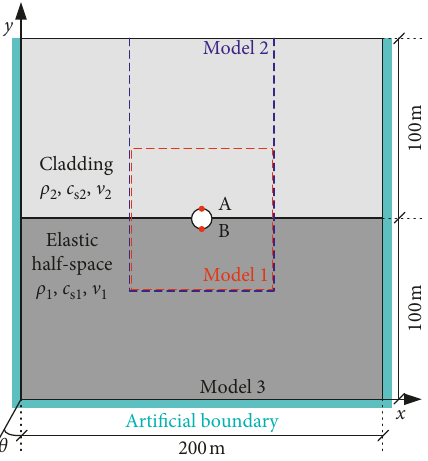
Figure 7: Layered half-space model with an underground cavity.